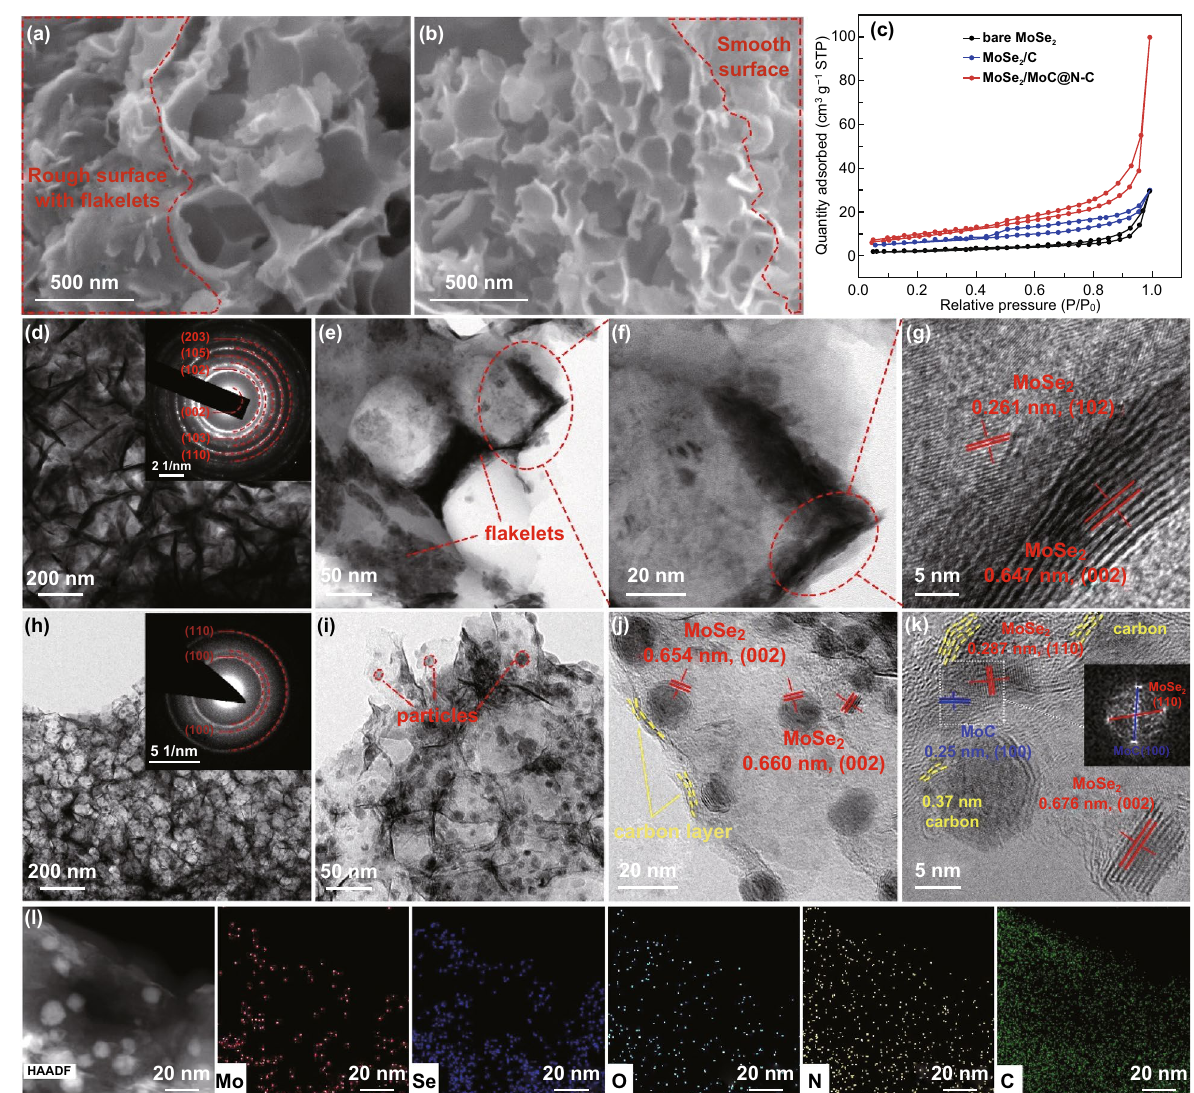
Fig. 2 SEM images of a MoSe 2 /C and b MoSe 2 /MoC/N–C; c statistical data of surface area; d – f TEM and g HRTEM images of MoSe 2 /C; h – j TEM and k HRTEM images of MoSe 2 /MoC/N–C (inset: FFT of the selected area); l elemental mappings of MoSe 2